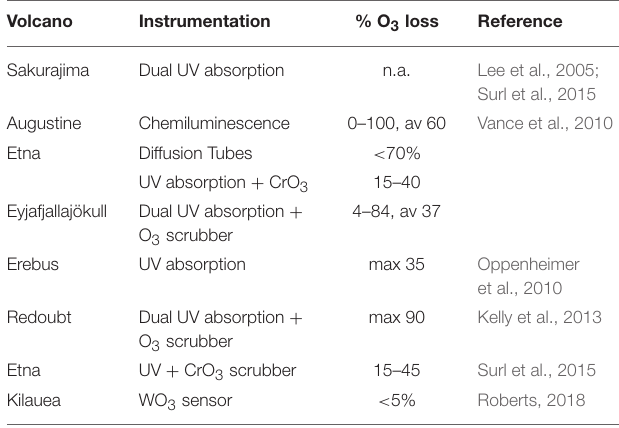
TABLE 2 | Ozone measurement devices and their advantages and disadvantages for application in volcanic plumes.